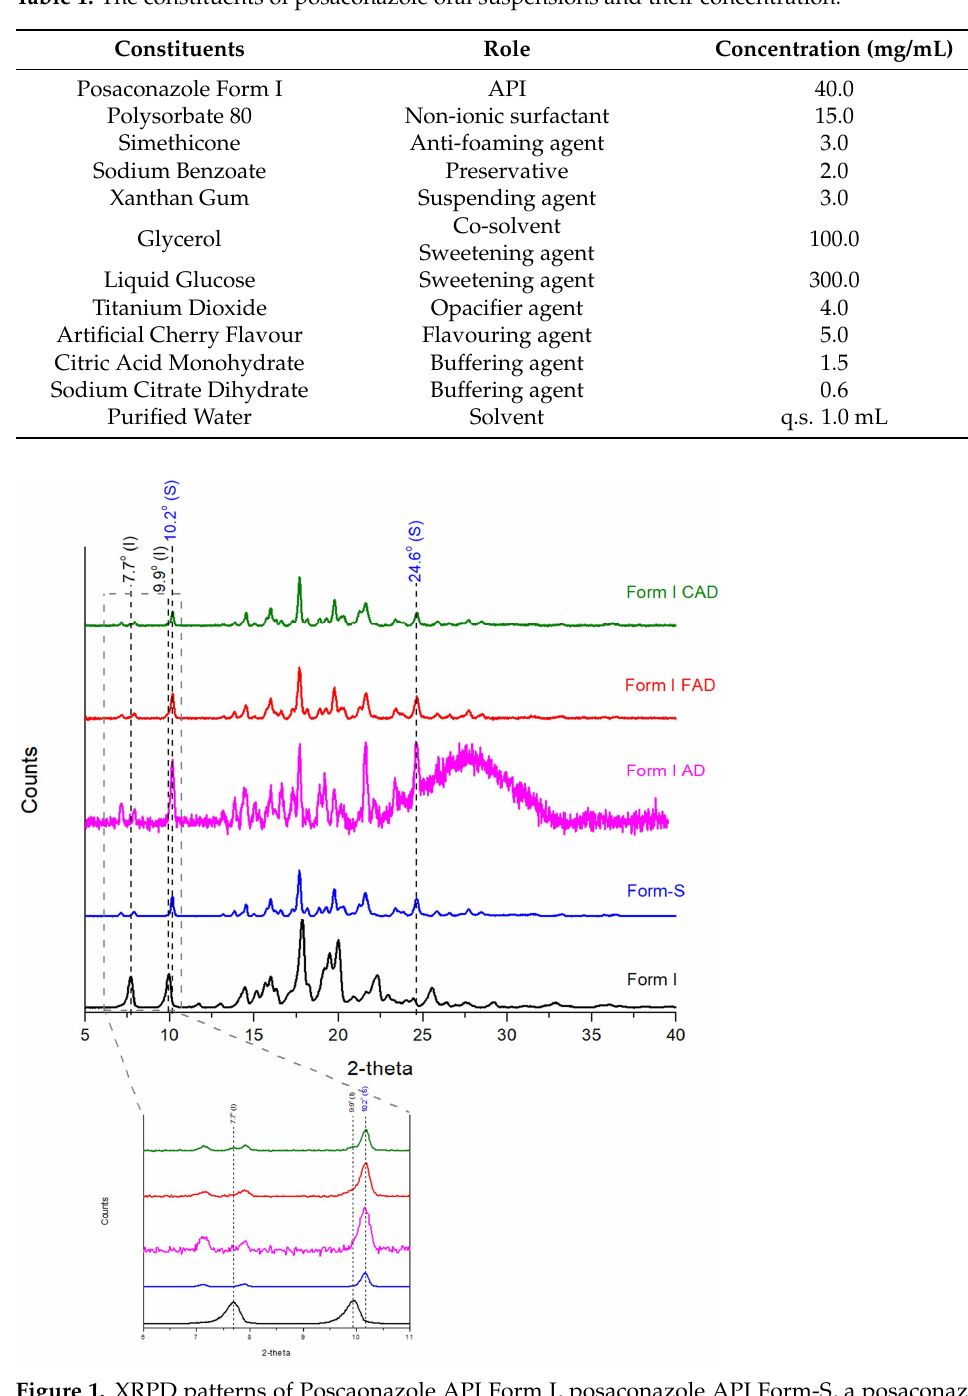
Table 1. The constituents of posaconazole oral suspensions and their concentration.